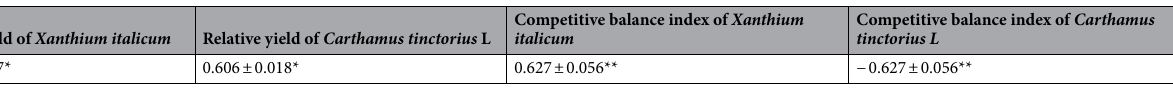
Table 1. Competition index of X. italicum and Carthamus tinctorius under different treatments. The values in the table are average values ± standard errors. * RY X and RY C are compared with 1. ** CB X is ompared with 0 (T-test: P <